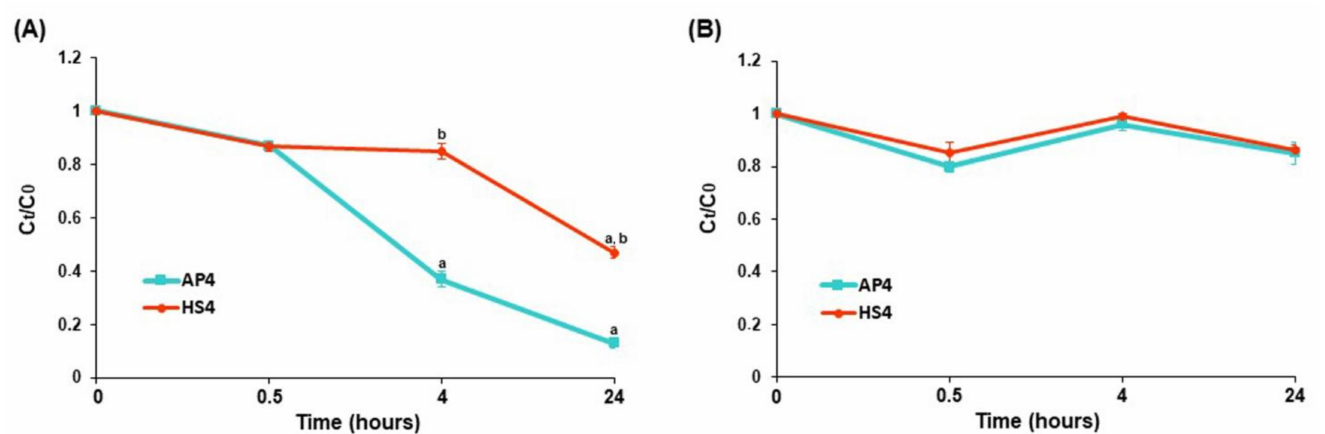
Figure 12. The BSA adsorption by AP4 and HS4 gel beads incubating for 24 h in acetate buffer solutions of pH 3.7 ( A ) and 5.0 ( B ). The data are presented as the mean ± S.D. ( n = 5). a p < 0.05 vs. initial time point; b p < 0.05 vs. the corresponding AP4 gel beads. The BSA adsorption is expressed as the relative protein concentration C t /C 0 , where C 0 and C t are the initial and remaining concentrations of BSA in PBS at different time points after incubation,